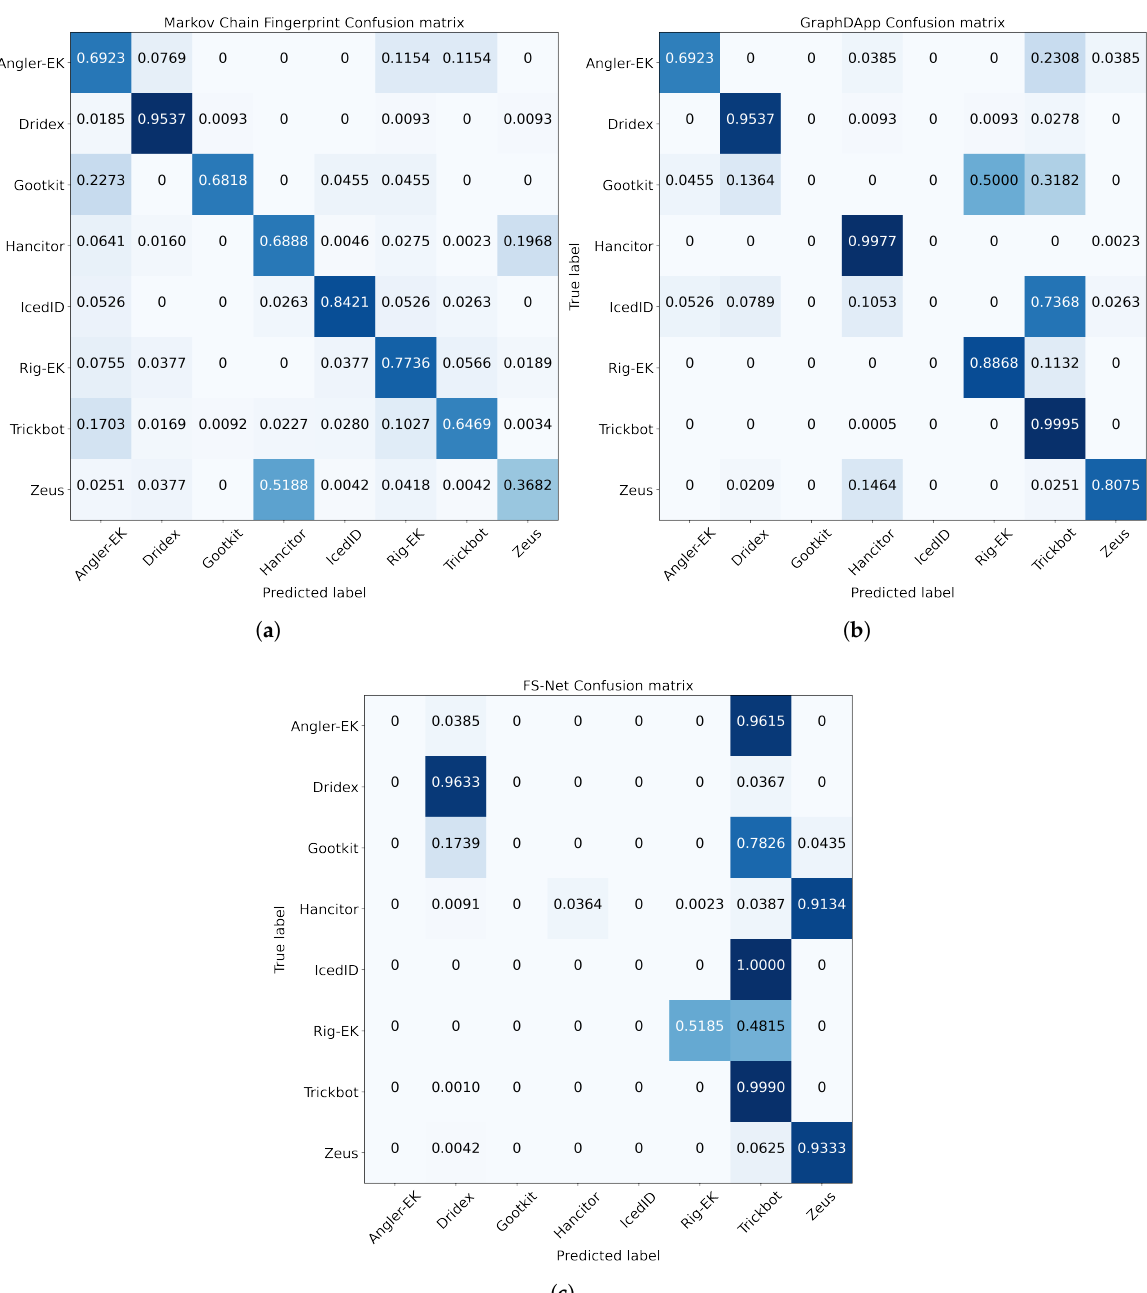
Figure 10. Confusion matrices of classification results using ( a ) Markov chain fingerprinting with maximum likelihood classifier, ( b ) traffic interaction graph with fully connected layer classifier (GraphDApp), and ( c ) embedding vector with FS-Net at 3% noisy